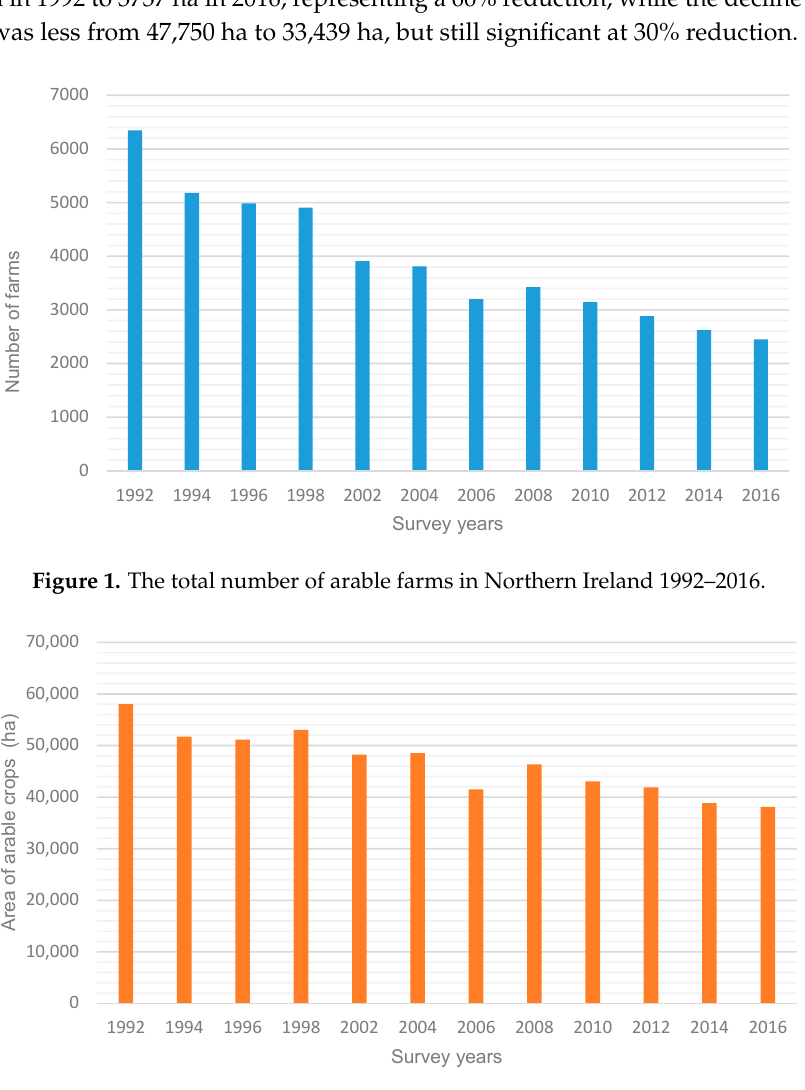
Figure 2. Total area of arable crops in Northern Ireland 1992–2016.